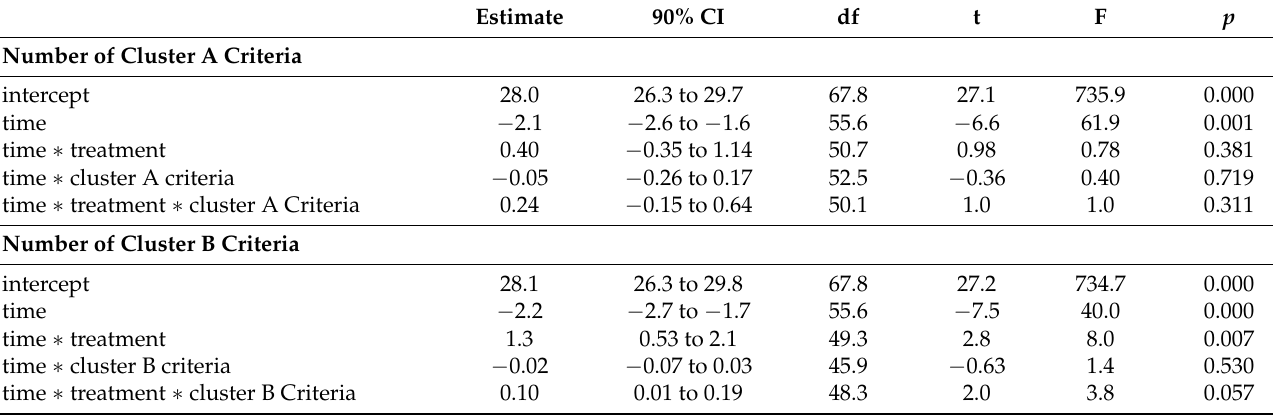
Table 3. Results of the moderator analyses during the whole study